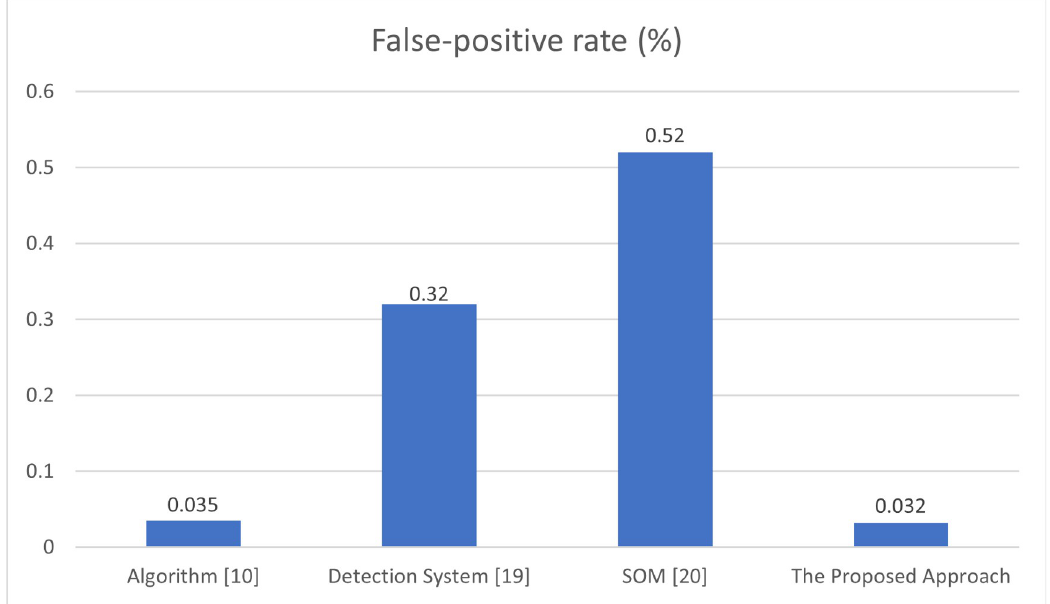
Fig 7. Comparison of false-positive rate of algorithm [10], detection system [19], detection method [20], and the proposed approach.